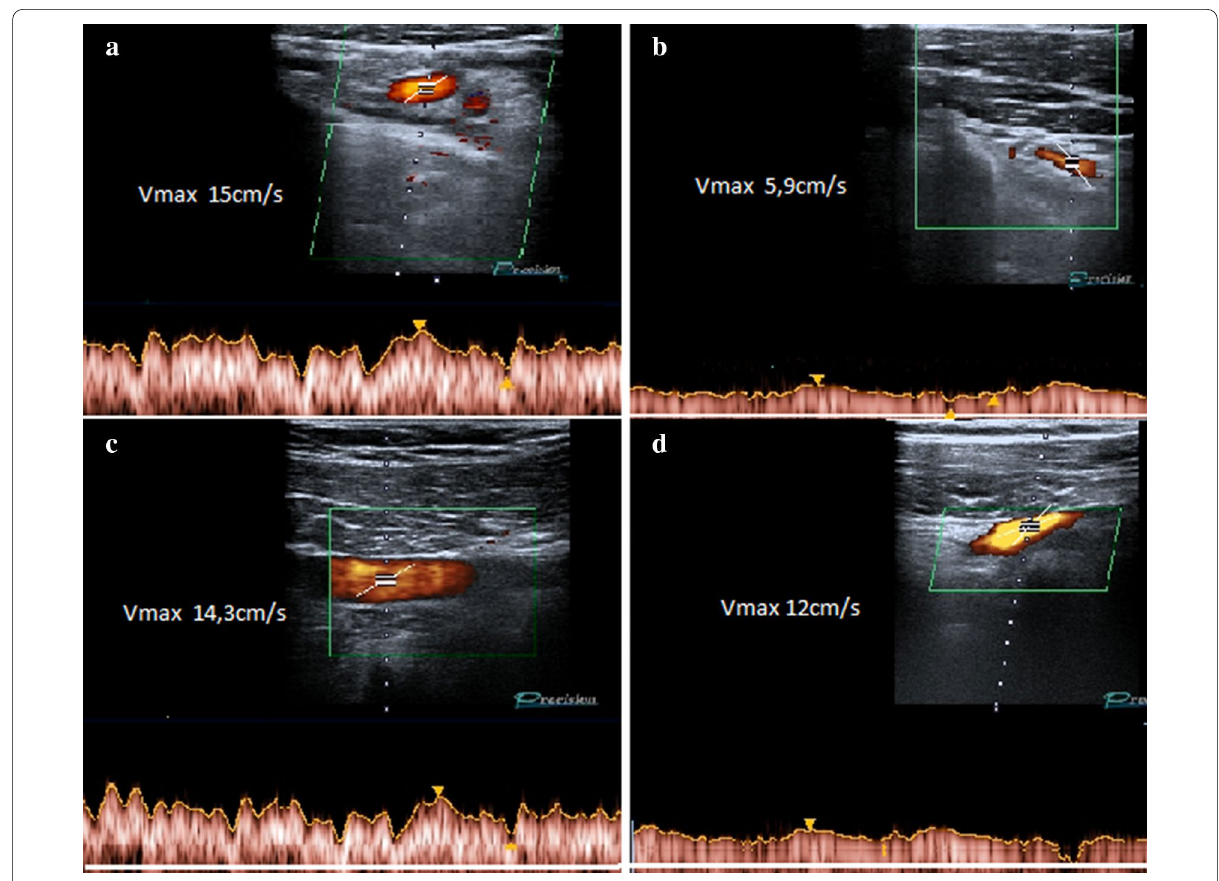
Fig. 5 Hypertrophy of the right anterior scalene muscle. a Duplex Doppler US examination of the right subclavian veins, with lowered arms, shows a regular diameter and flow. b With arms raised to 90° Duplex Doppler US shows a peak speed reduction due to compression by the anterior scalene muscle. c Duplex Doppler US of left subclavian vein, with lowered arms, shows a regular caliber and flow. d Which remain regular even with arms raised to